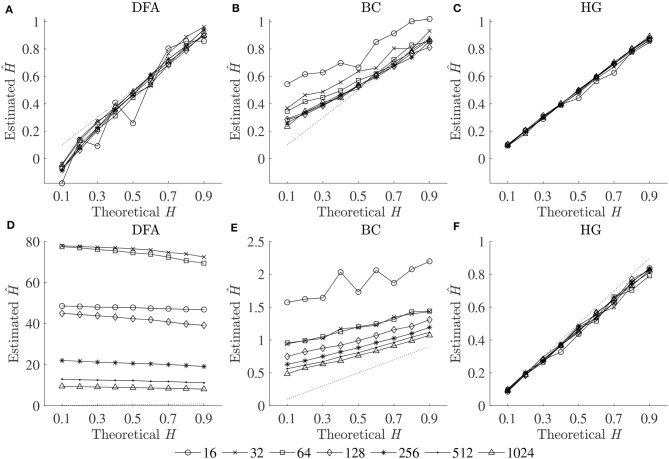
Plots of theoretical H and mean estimated Ĥ using the optimal parameters (upper panels) and the worst-case parameters (lower panels) for three fractal methods: (A,D) DFA, (B,E) BC, and (C,F) HG.